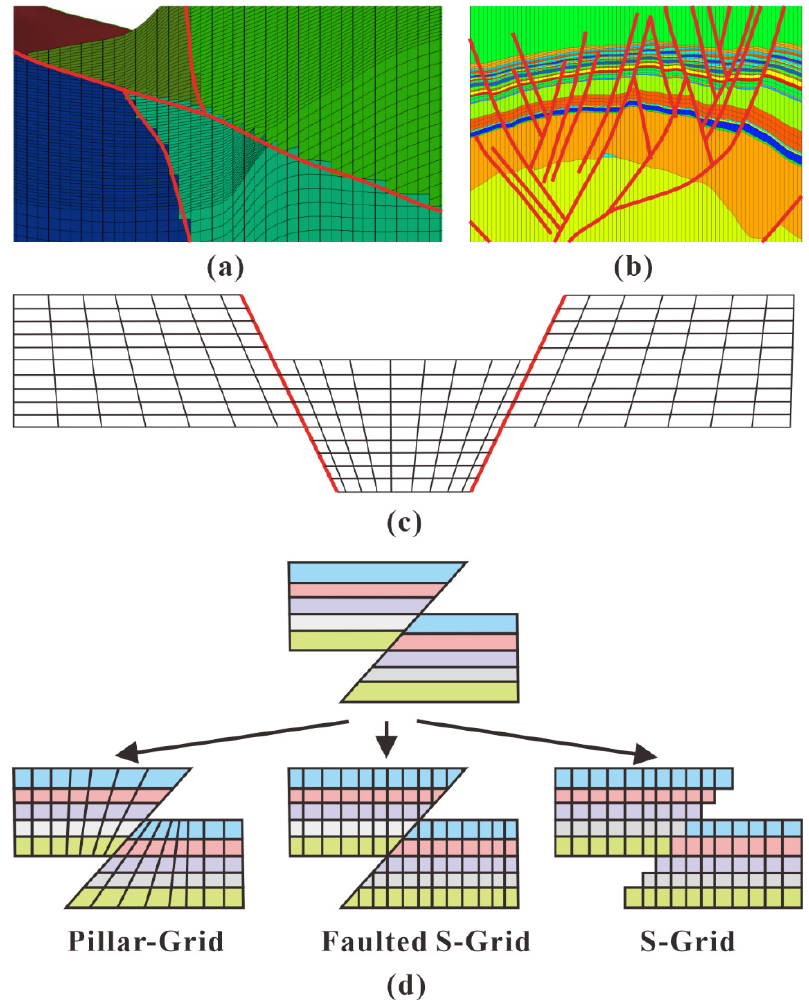
Figure 1. Comparison of s-grid, faulted s-grid, and pillar grid (edited from [17]): ( a ) example of s-grid; ( b ) example of faulted s-grid; ( c ) example of pillar grid; ( d ) theoretical model of s-grid, faulted s-grid, and pillar grid for the processing of